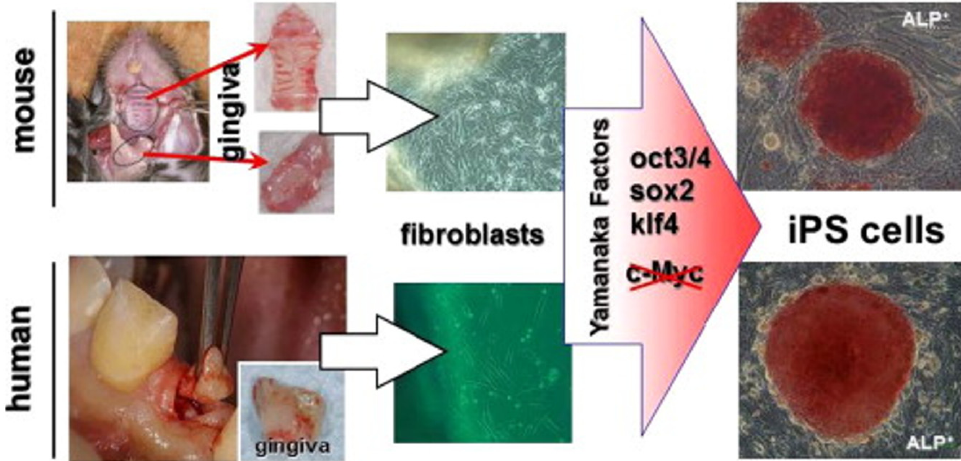
Figure 3. Generation of iPS cells from gingiva [138]. Gingival tissues from adult mice and patients (resected during dental implant surgery) can be used for iPS cell generation. Isolated gingival fibroblasts were easily reprogrammed by the transduction of three factors (Oct3/4, Sox2, and Klf4) without the c-Myc oncogene. Red iPS colonies in the figure show robust staining for alkaline phosphatase (ALP), which is associated with undifferentiated pluripotent stem cells. This figure is reproduced from the study by Egusa et al. [137] under open-access license policies.